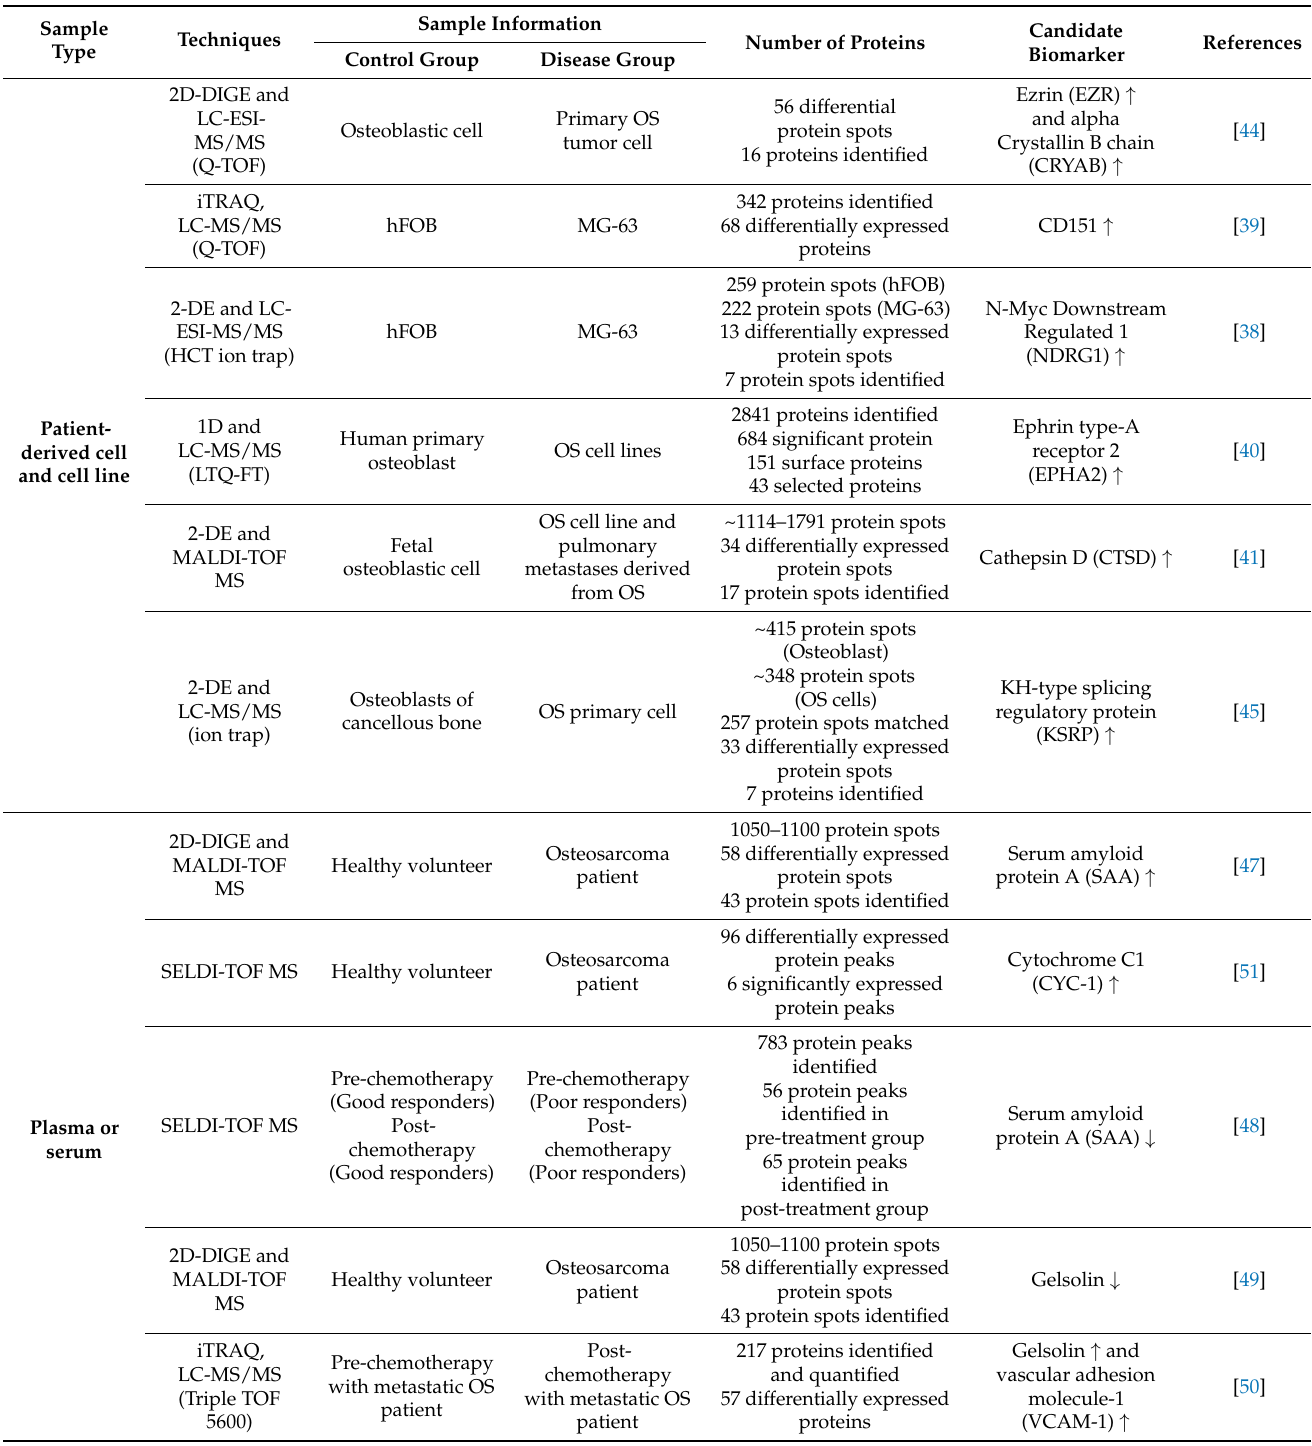
Table 1. Overview of proteomic studies in osteosarcoma